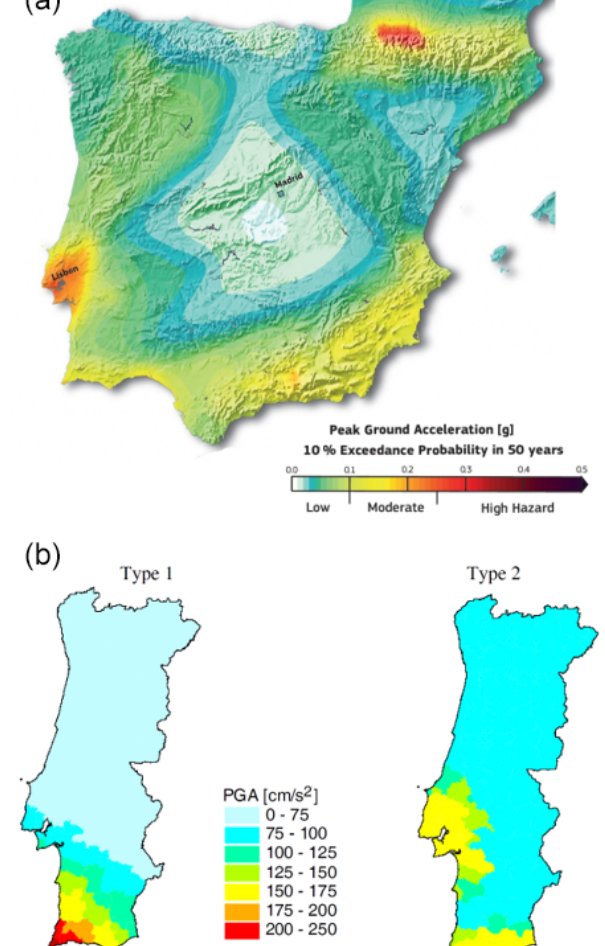
Figure 2. Seismic hazard maps expressed as peak ground accelera- tion (PGA) expected to be exceeded in 50 years with 10% probabil- ity. (a) From the ESHM13 model by Woessner et al. (2015), units scaled to gravity acceleration ( g = 9 . 8ms − 2 ). (b) From the PSHA study used in Portugal for the revision of the building codes accord- ing to EC8 guidelines (Campos Costa et al., 2008), units in centime- tres per second squared (cms − 2 ). Type 1 refers to a “far” (offshore) source, while type 2 refers to a “near” source. These maps show the inconsistency of PSHA models, as two options for the chosen